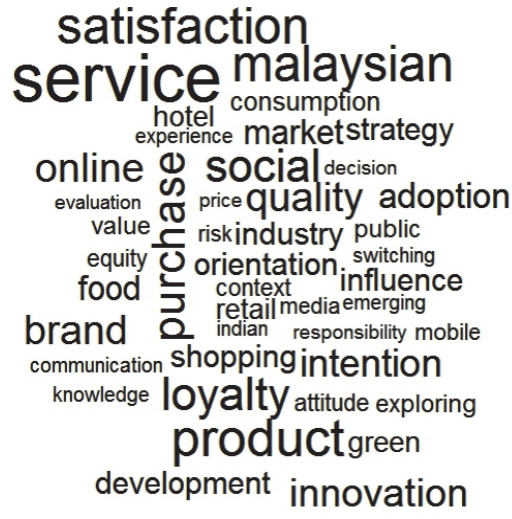
<Figure 6> Top 50 Marketing Topics in Zone SA (Indonesia, Malaysia, India, Philippines,